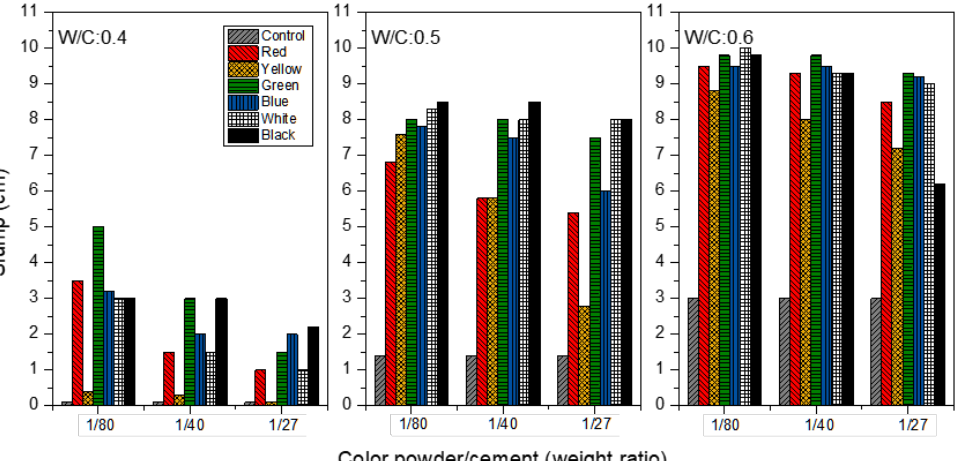
Figure 3. Slump of colored mortar at W/C = 0.4, 0.5 and 0.6, with weight ratios of color powder/cement at 1:80, 1:40, 1:27 added.